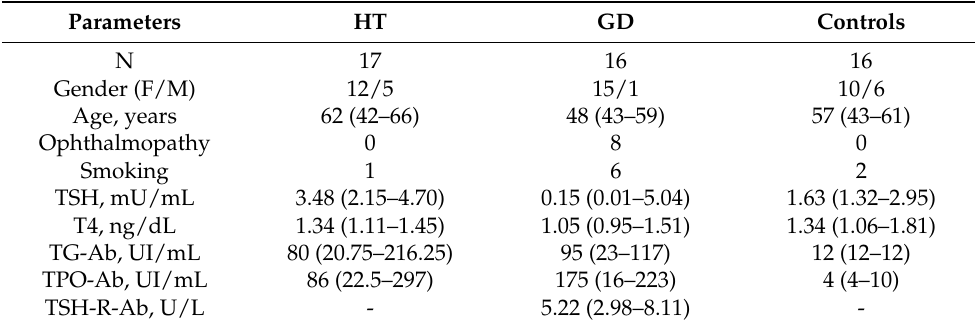
Table 3. Clinical parameters of patients included in